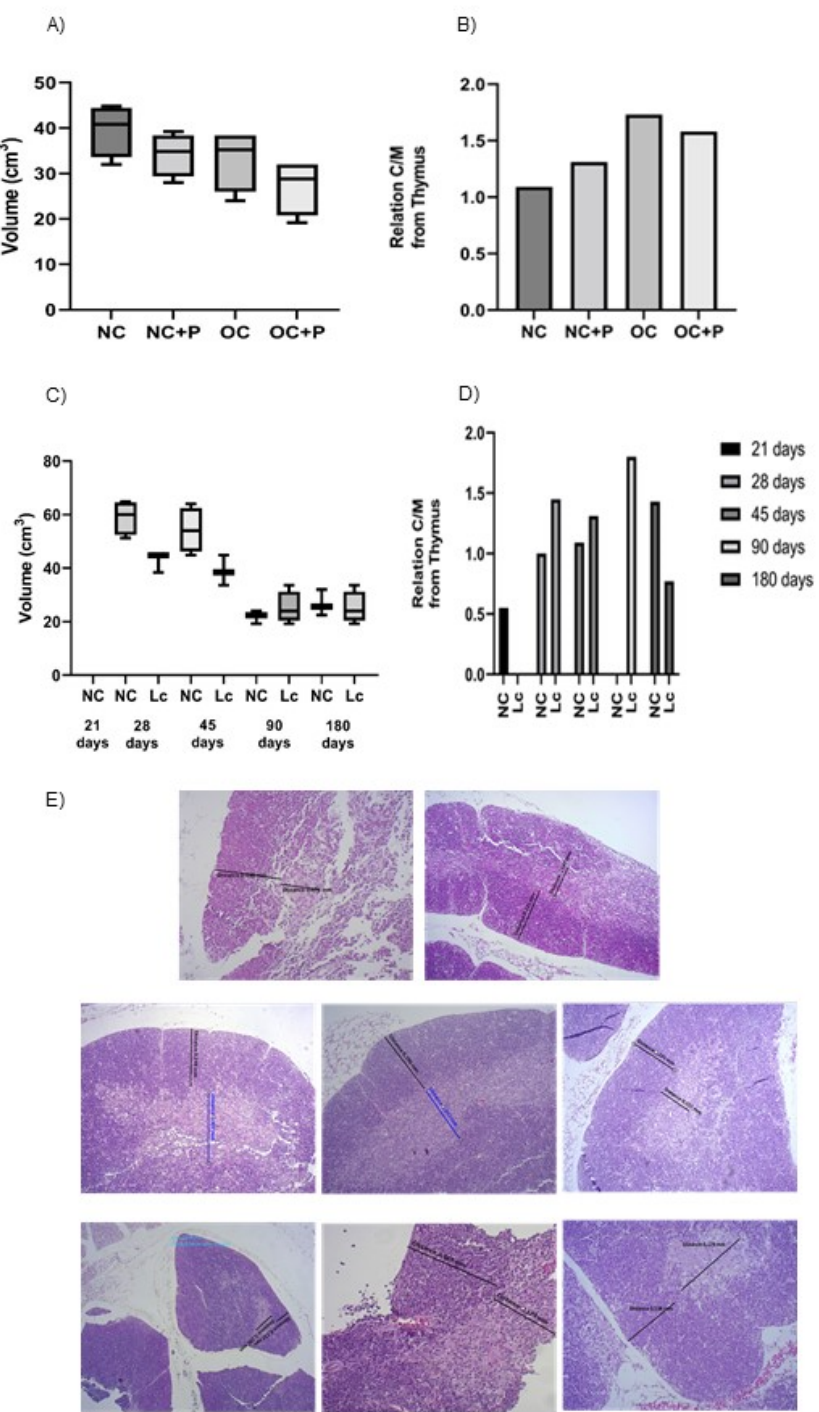
Figure 3. Post-mortem determination of thymus volume. The organ was extracted and weighed after the sacrifice. Each point represented the average ± SD of volume data pooled from 3 independent experiments with 3 mice per group. ( A , C ): size of the thymus in the obesity and senescence mouse models, respectively, ( B , D ): cortex/medullary /relationship from the thymus in obesity and senescence mouse models, respectively. Results (mean ± SD) were representative of three independent experiments. Micrographs of thymus sections in the different animal models. Tissue sections from obese ( E ) and senescence mouse models stained with hematoxylin and eosin. Magnification 1000×.